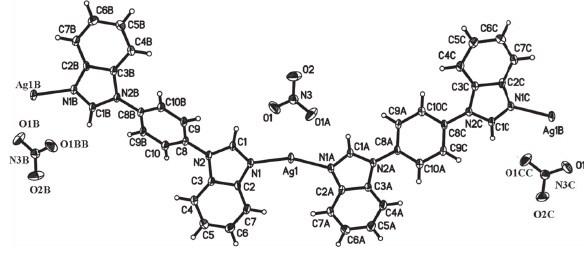
Table 1: Data collection and handling.